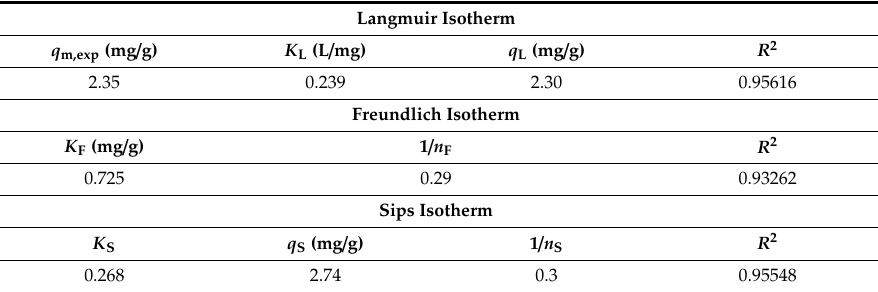
Figure 12. Experimental data modeled with adsorption isotherms. Table 3. Kinetic parameters obtained for the used adsorption isotherms.